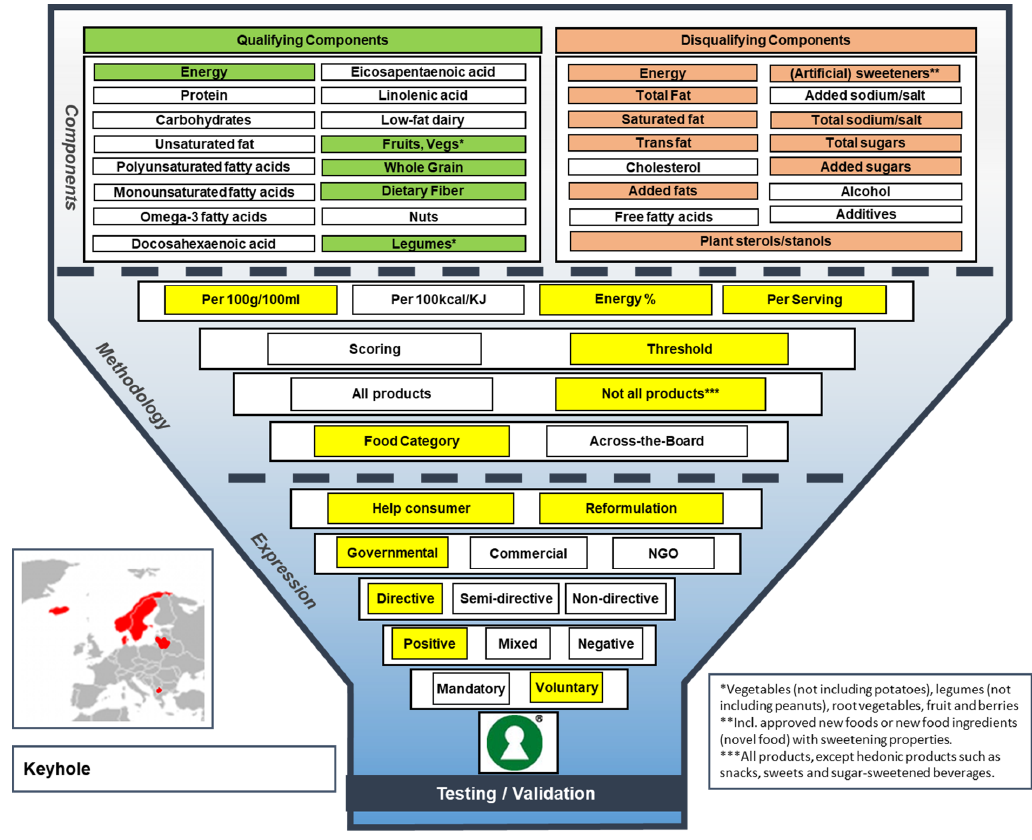
Figure 2. The Funnel Model describing functional and visual aspects of the Keyhole